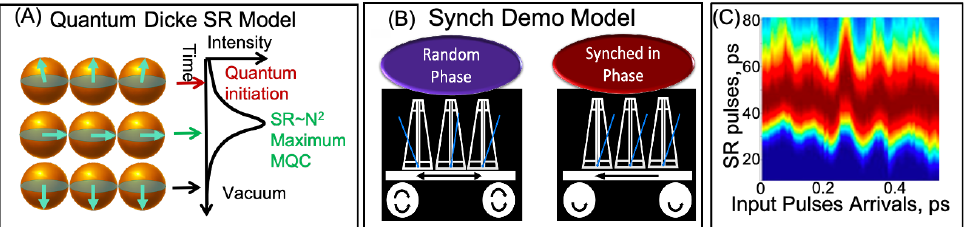
Figure 1. ( A ) Collective spontaneous emissions. A pictorial explanation of superradiance. ( B ) Synch demo. A sketch of a system of oscillating three metronomes and platform. ( C ) Data for a temporal coherent control of atomic macroscopic quantum coherence.